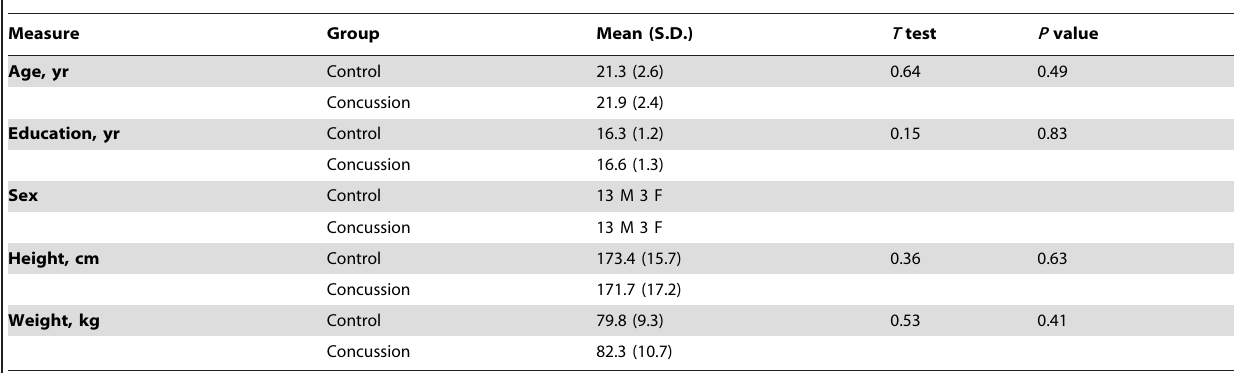
Table 1. Participant